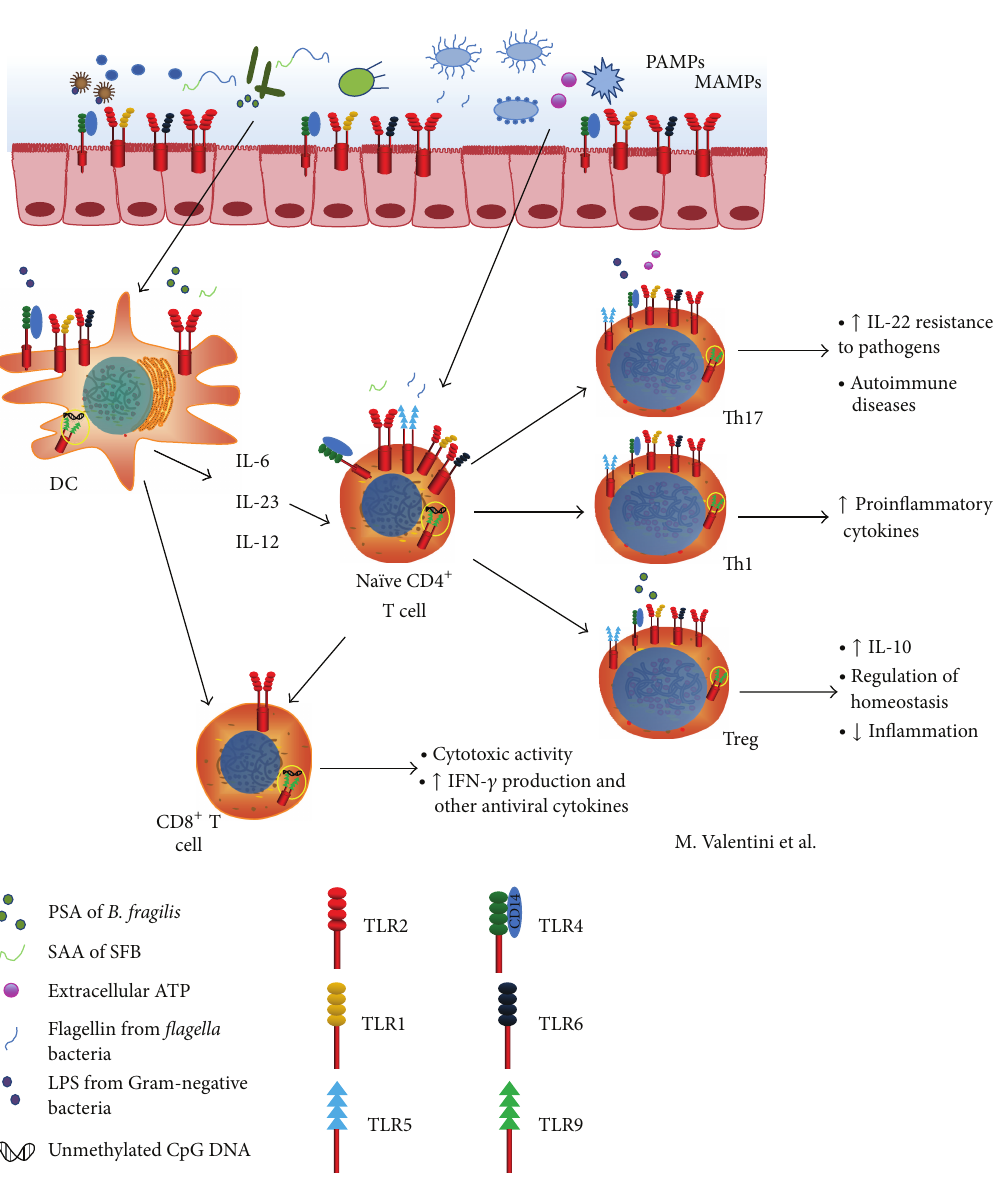
intestinal inflammation [70,